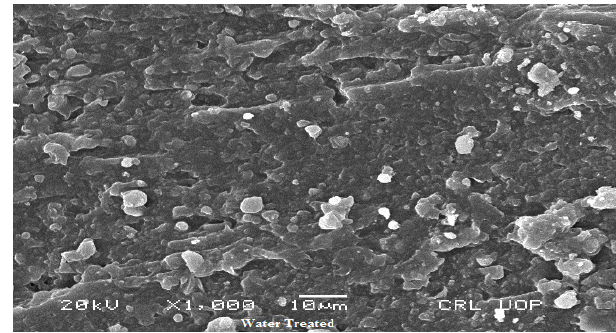
Figure 13. Untreated CR .